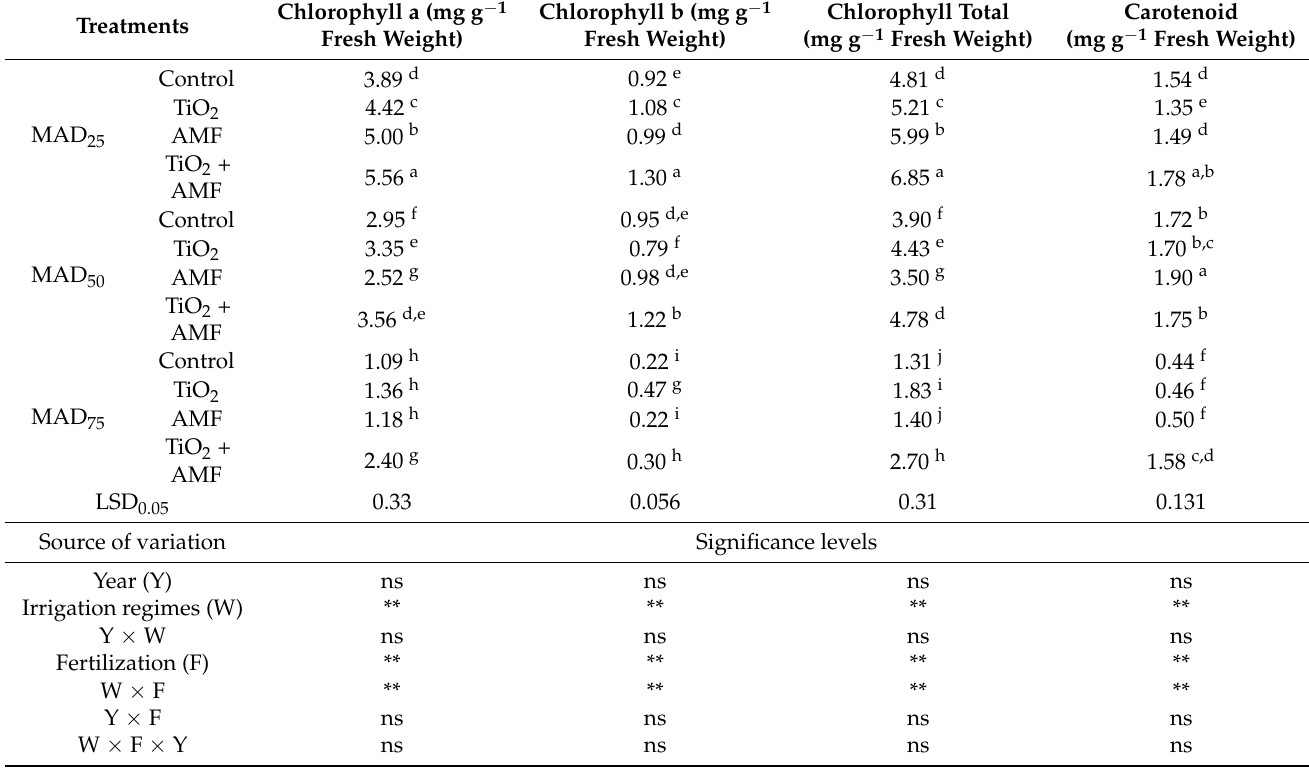
Table 4. Chlorophyll a, b, and total and carotenoid of sage in different irrigation regimes and fertilizer